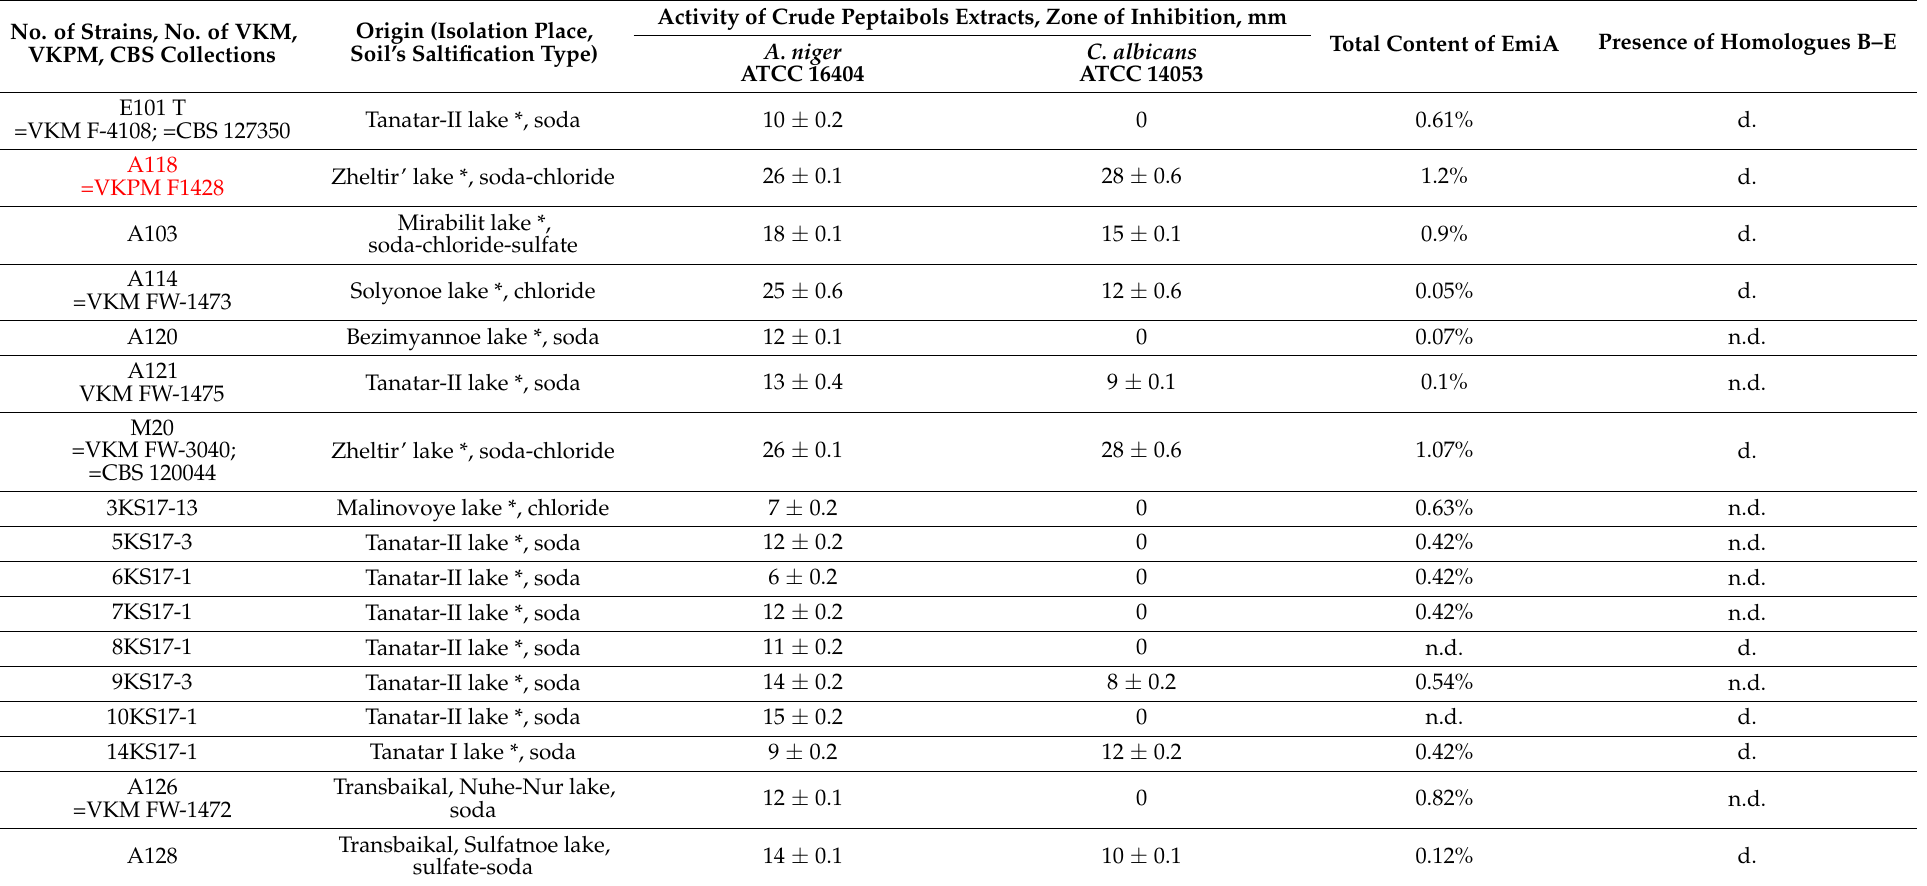
Total Content of